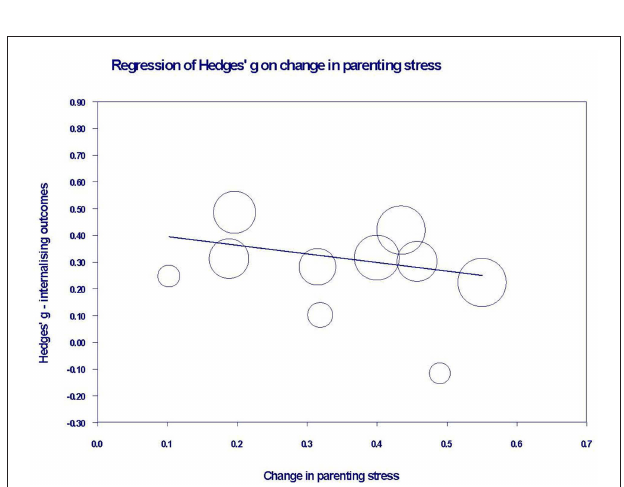
FIGURE 5 | Bubble plot of youth internalizing outcome effects against change in parenting stress. Each bubble represents a study, and the diameter of each bubble is proportional to the study weight.